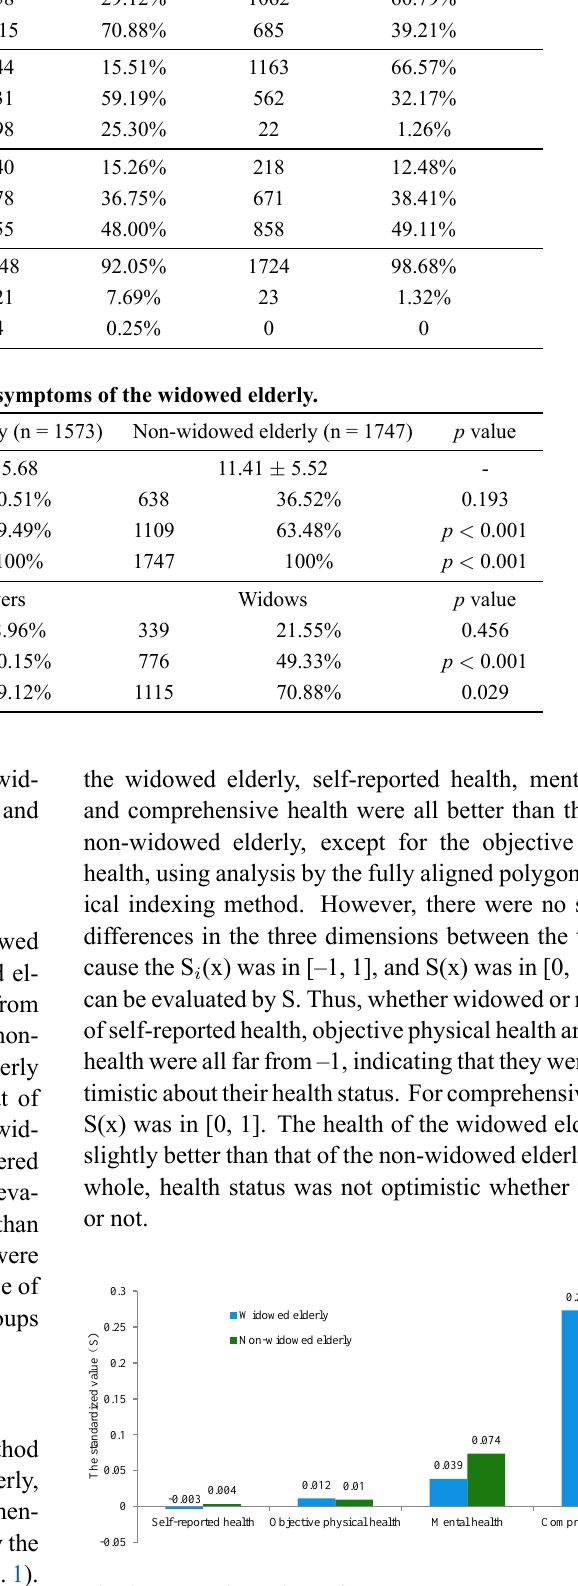
Fig. 1. Three dimensions of elderly